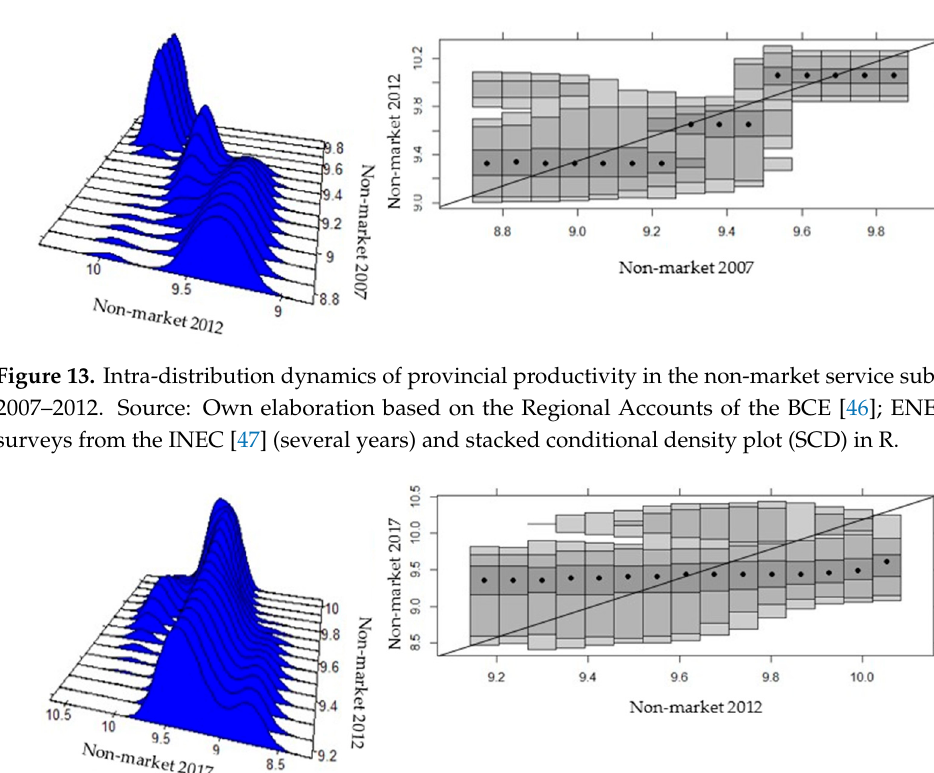
Figure 12. Intra-distribution dynamics of provincial productivity in the non-market service subsector, 2007–2017. Source: Own elaboration based on the Regional Accounts of the BCE [46]; ENEMDU surveys from the INEC [47] (several years) and stacked conditional density plot (SCD) in R.